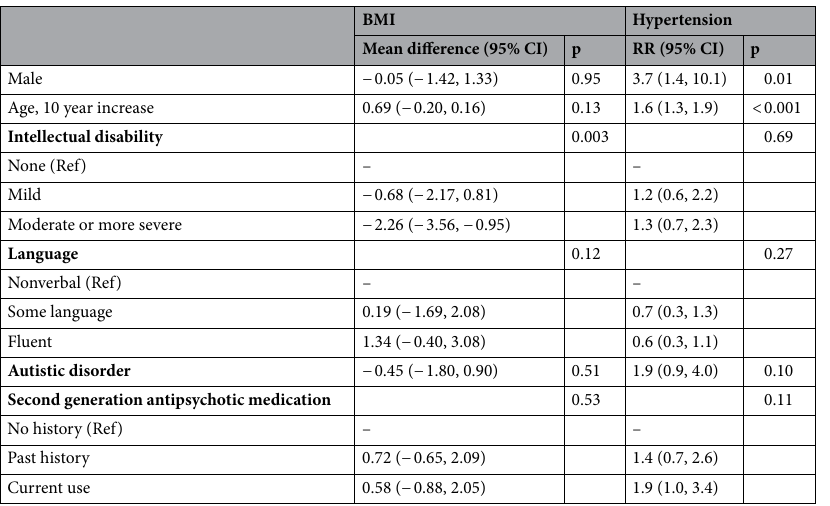
Table 3. Associations of potential demographic and clinical predictors with metabolic risk factors in 483 ASD patients. ASD autism spectrum disorder, BMI body mass index. Estimates and 95% CIs are from risk regression (hypertension) and linear regression (BMI) models. All models included sex and age as covariates. Missing values were accommodated using multiple imputation for chained equations with sex, age (linear and squared terms), intellectual disability, language ability, DSM-IV diagnosis of autistic disorder, second generation antipsychotic use, hypertension, and most recent BMI measurement from the past 5 years as